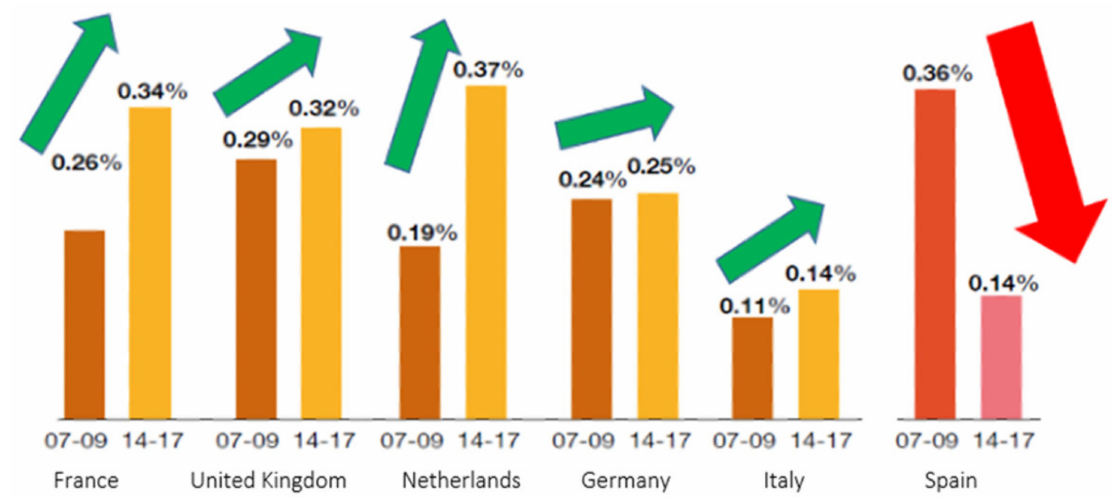
Figure 4. Evolution of historical investments in urban water infrastructures by country (% GDP). Data sources: GWI Eurostat, Spanish Ministry of Development, AEAS